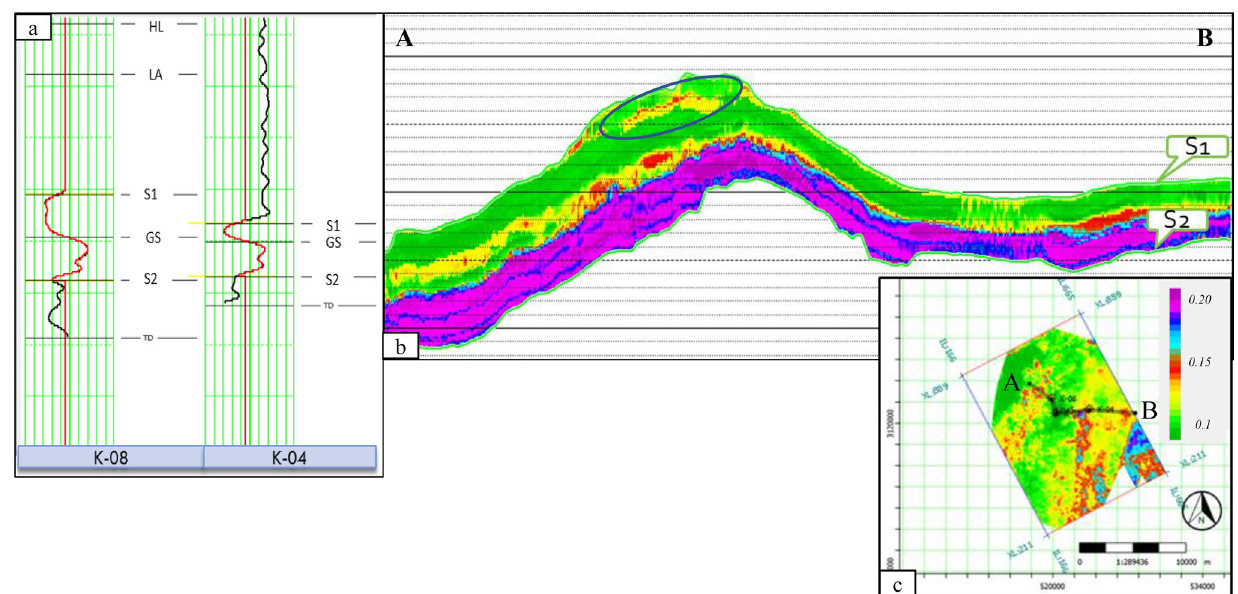
Fig. 21 Application of Probabilistic Neural Network (PNN) for total porosity estimation: a PNN training results QC for total porosity prediction at wells showing total correlation (≈ 99%) between actual